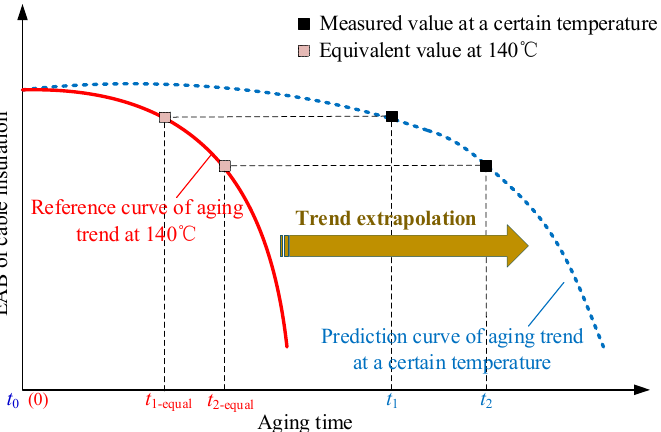
Figure 8. Schematic diagram of the calculation for the multiplicative shift factor at a certain tem-